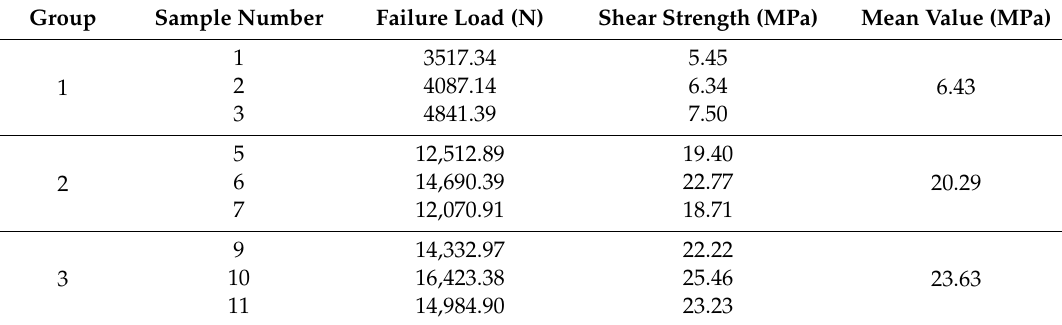
Table 3. Shear strength of the samples for each